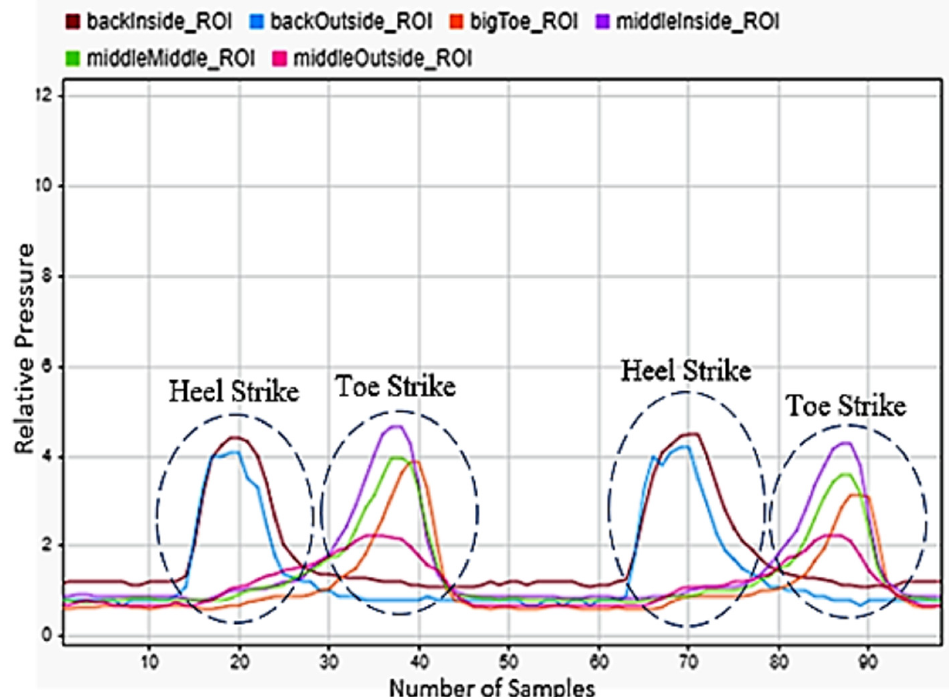
Figure 11. Pushing a cart sensor data for the left foot.